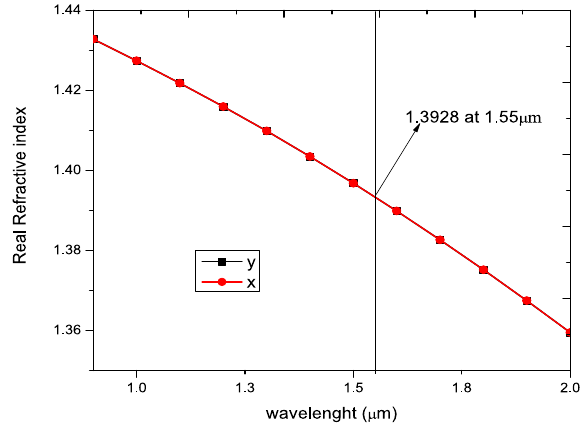
Fig. 5 Real effective index as a function of wavelength Λ